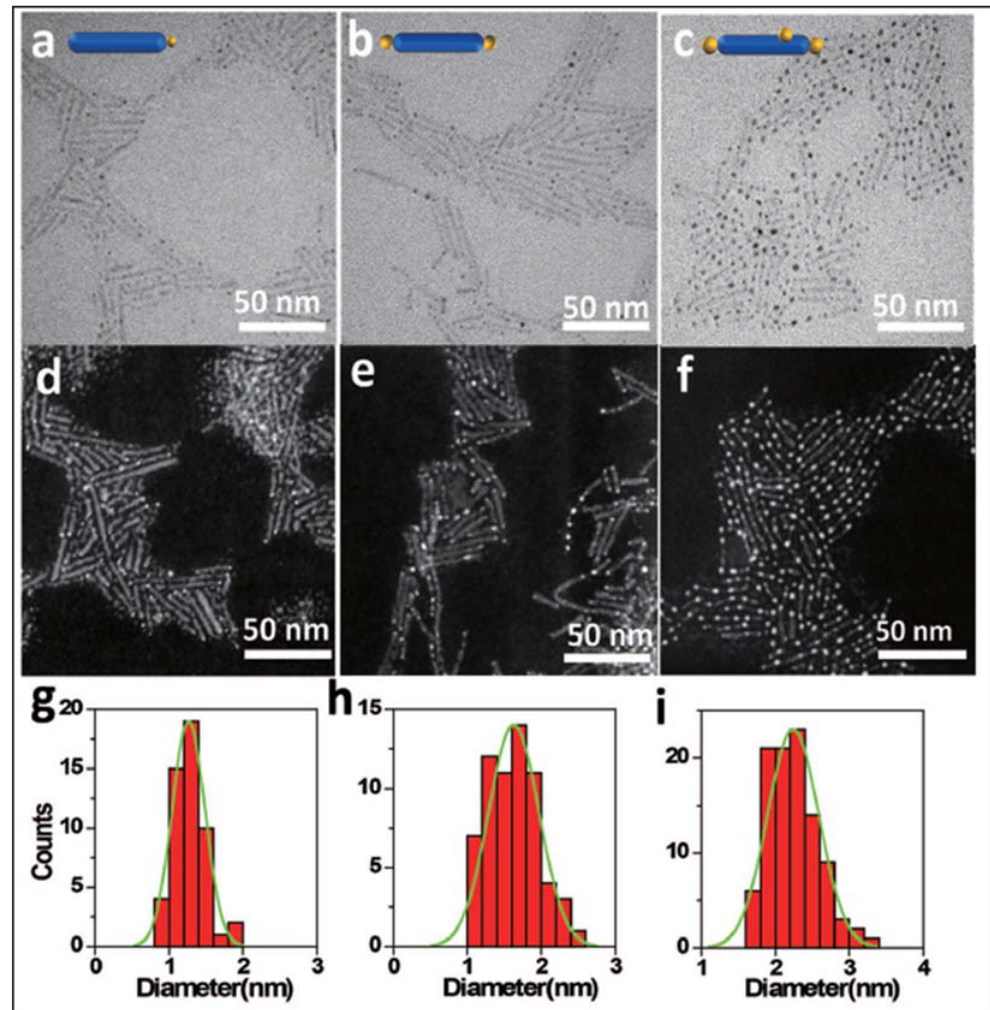
Figure 20. ( a – c ) TEM images of Au – ZnSe hybrid nanorods with Au tips of variable size. ( d – f ) STEM images corresponding to ( a – c ). ( g – i ) Particle size histograms corresponding to ( a – c ). Reproduced with permission from reference